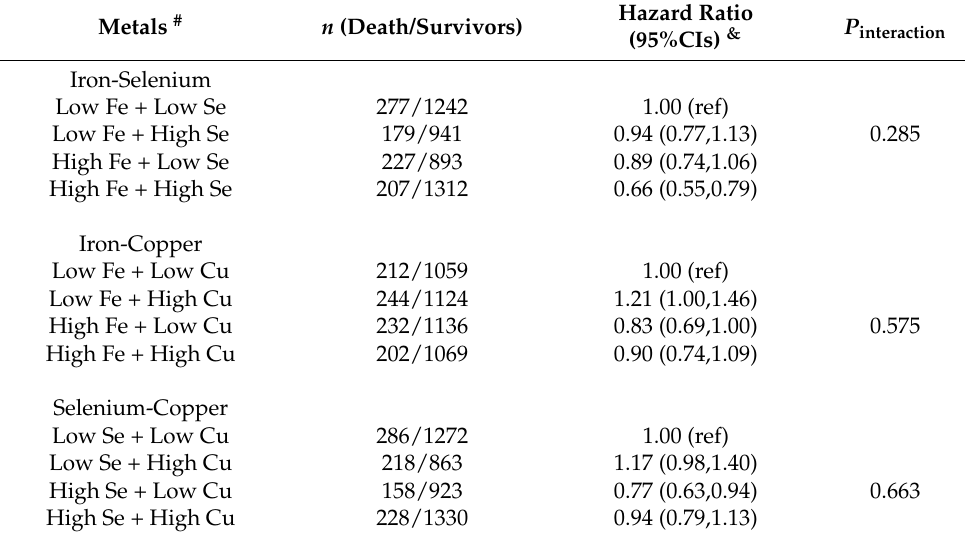
Table 3. Hazard ratios (95%CIs) for all-cause and cardiovascular mortality in patients with type 2 diabetes according to the combined categories of plasma metal